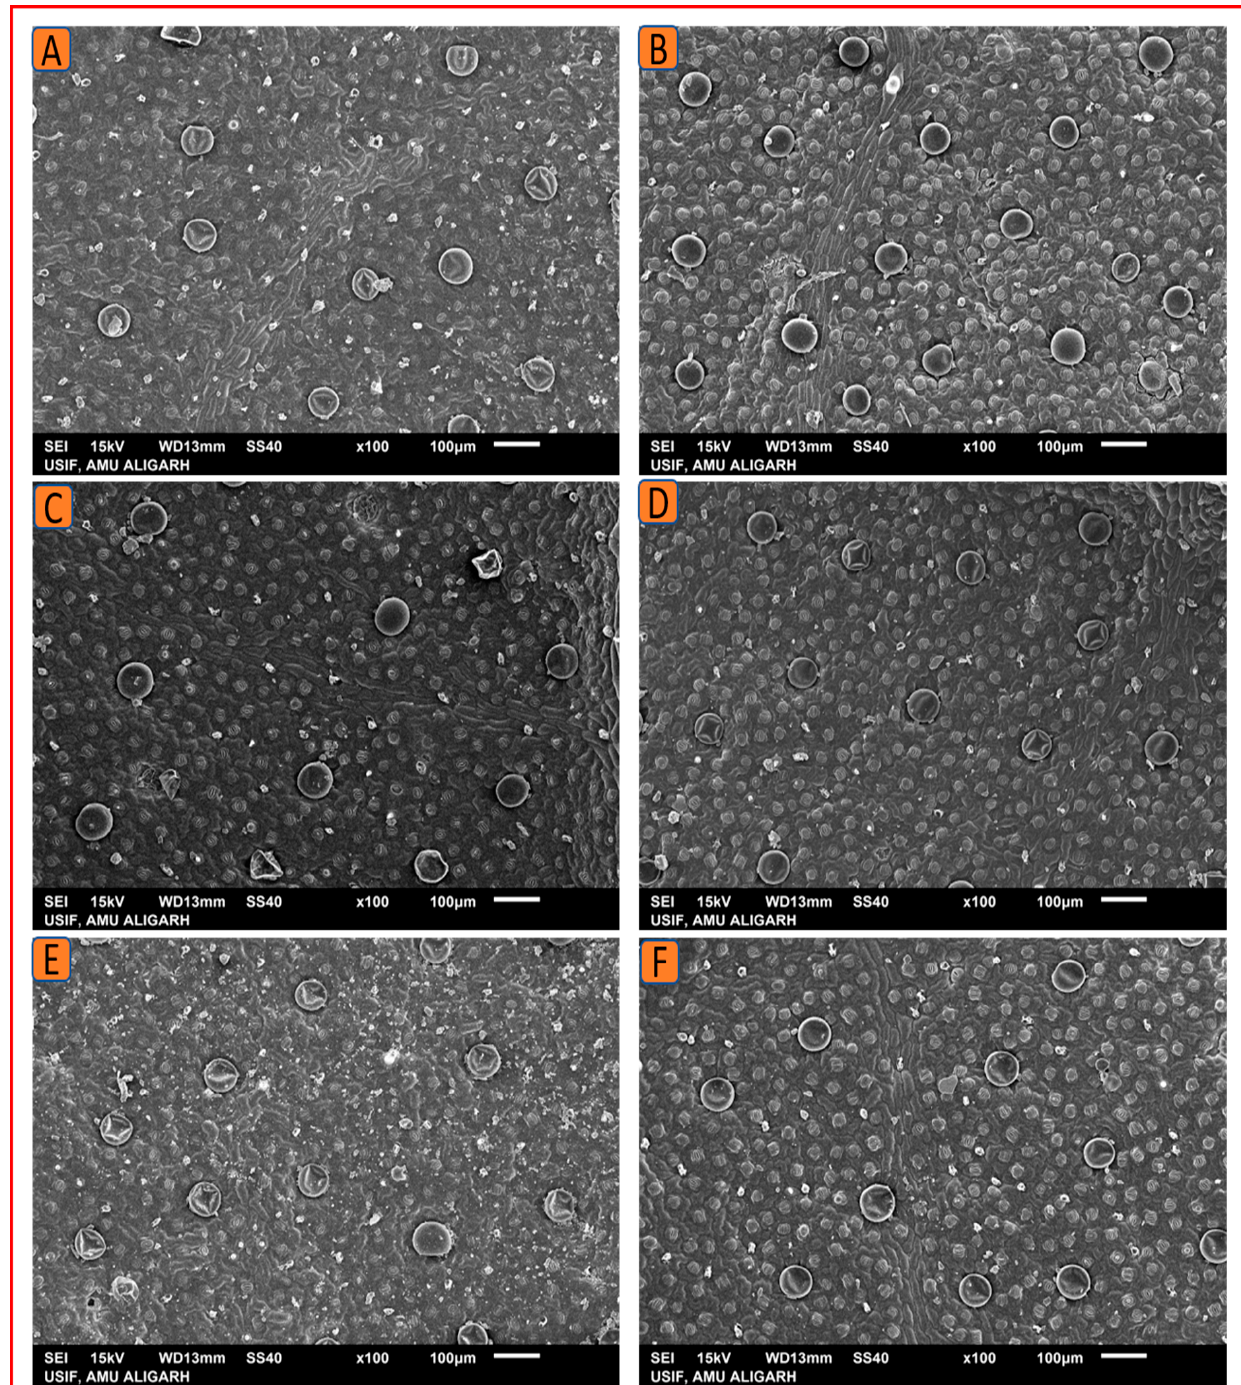
Figure 12. SEM micrographs showing trichome density of in the three cultivars of peppermint. The SEM micrographs show an enhancement in the trichome density by N application. ( A ) Trichome density at 0% N in Kukrail, ( B ) at 1.5% N in Kukrail, ( C ) at 0% N in Pranjal, ( D ) at 1.5% N in Pranjal, ( E ) at 0% N in Tushar, ( F ) at 1.5% N in Tushar.